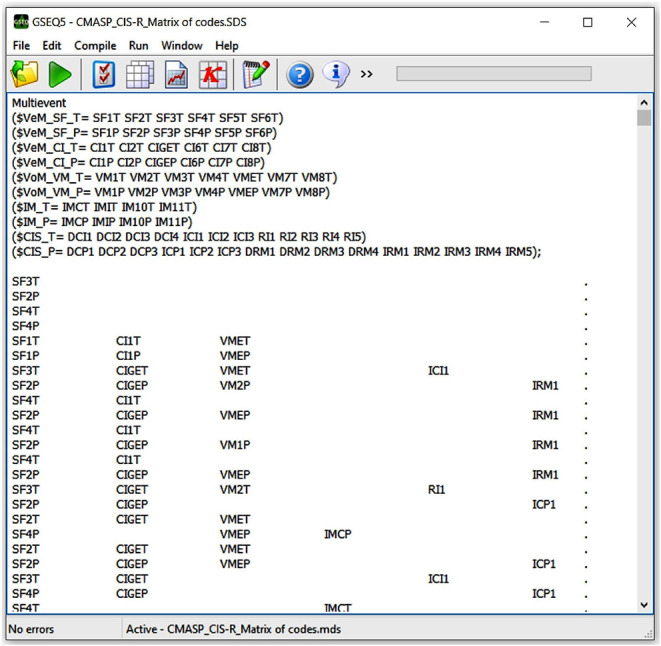
Screenshot of CMASP and CIS-R merged data in the form of a code matrix in GSEQ (v. 5.1.23; Bakeman and Quera, 2011). Each row corresponds to the multiple and concurrent event codes of a speaking turn. T and P distinguish the therapist's and patients' codes in their respective speaking turns.